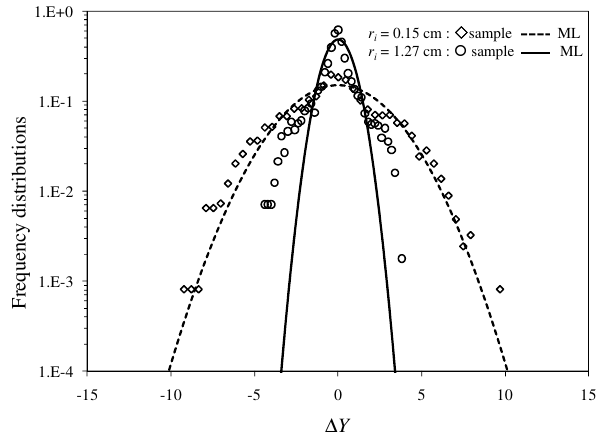
Fig. 3. Frequency distributions of 1Y ( s x =8.5cm) on multiple faces and r i =0.15; 1.27cm (symbols). ML fits of Gaussian proba- bility density functions are also reported